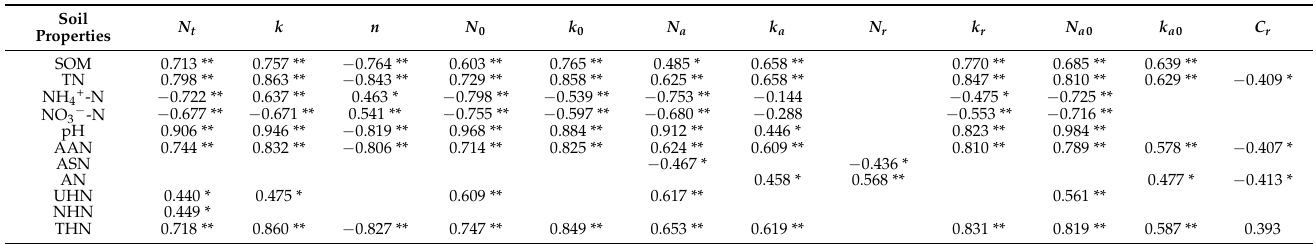
Table 4. Pearson correlations between the mineral-N, parameters in the fitted models, and soil properties. Soil Properties SOM